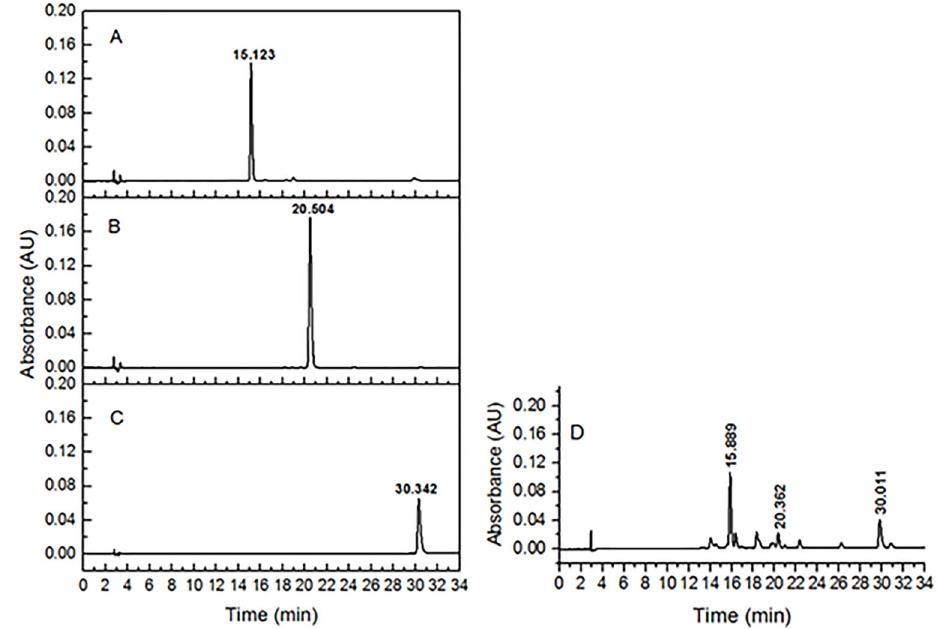
Figure 1. HPLC chromatograms of rutin ( A ), quercitrin ( B ), quercetin ( C ), and PHLE extract ( D ). PHLE: P. hydropiper extract; HPLC: high-performance liquid chromatography.